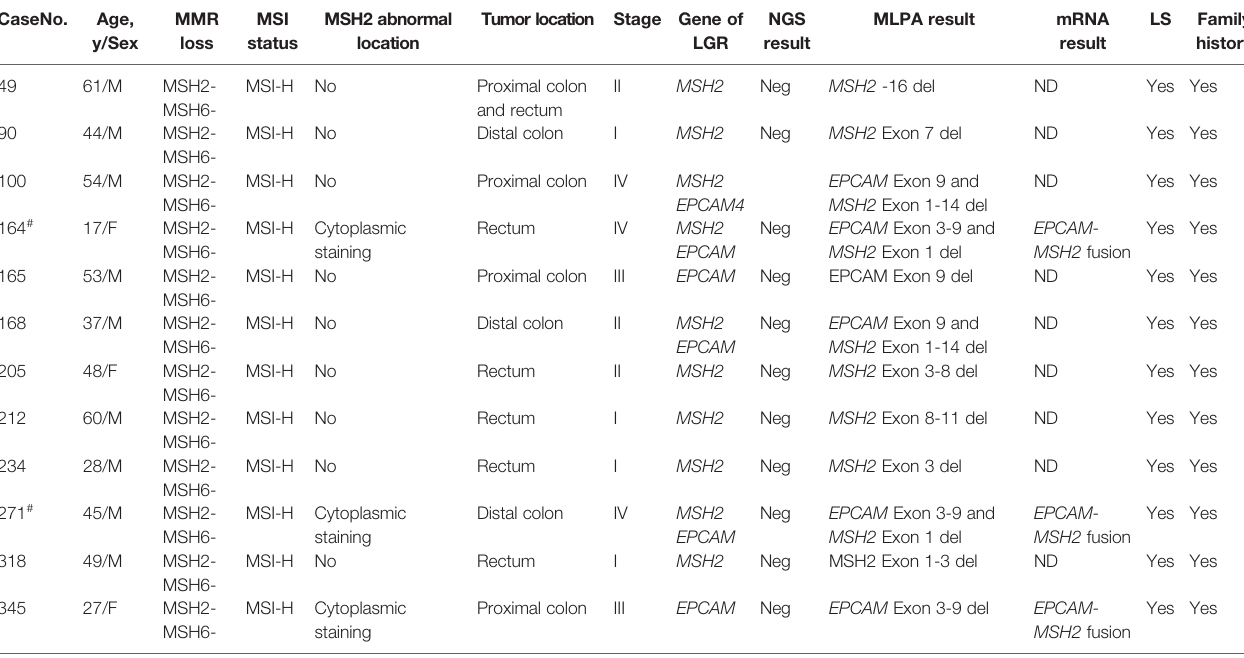
TABLE 2 | Clinical, pathological and molecular fi ndings in CRC tumors with MSH2 LGR-associated LS.